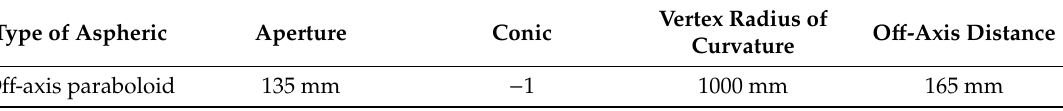
Table 1. The parameters of the chosen o ff -axis paraboloid (OAP). Type of